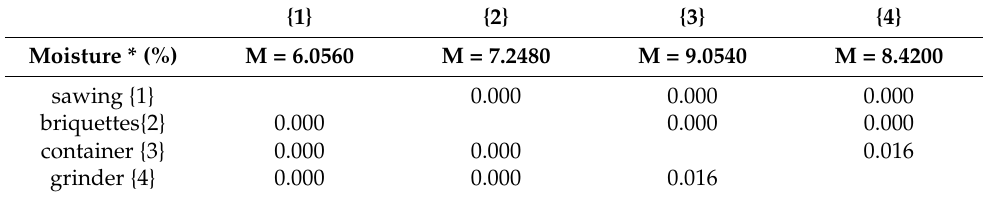
Table 5. Duncan test with variable, moisture (%).